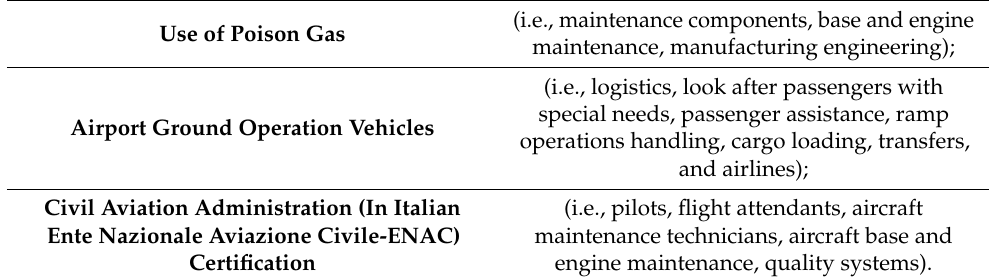
Table 1. Duties to be subjected to medical examination to exclude drug or psychotropic substance abuse as provided for in Annex 1 to the State-Regions Conference Provision of